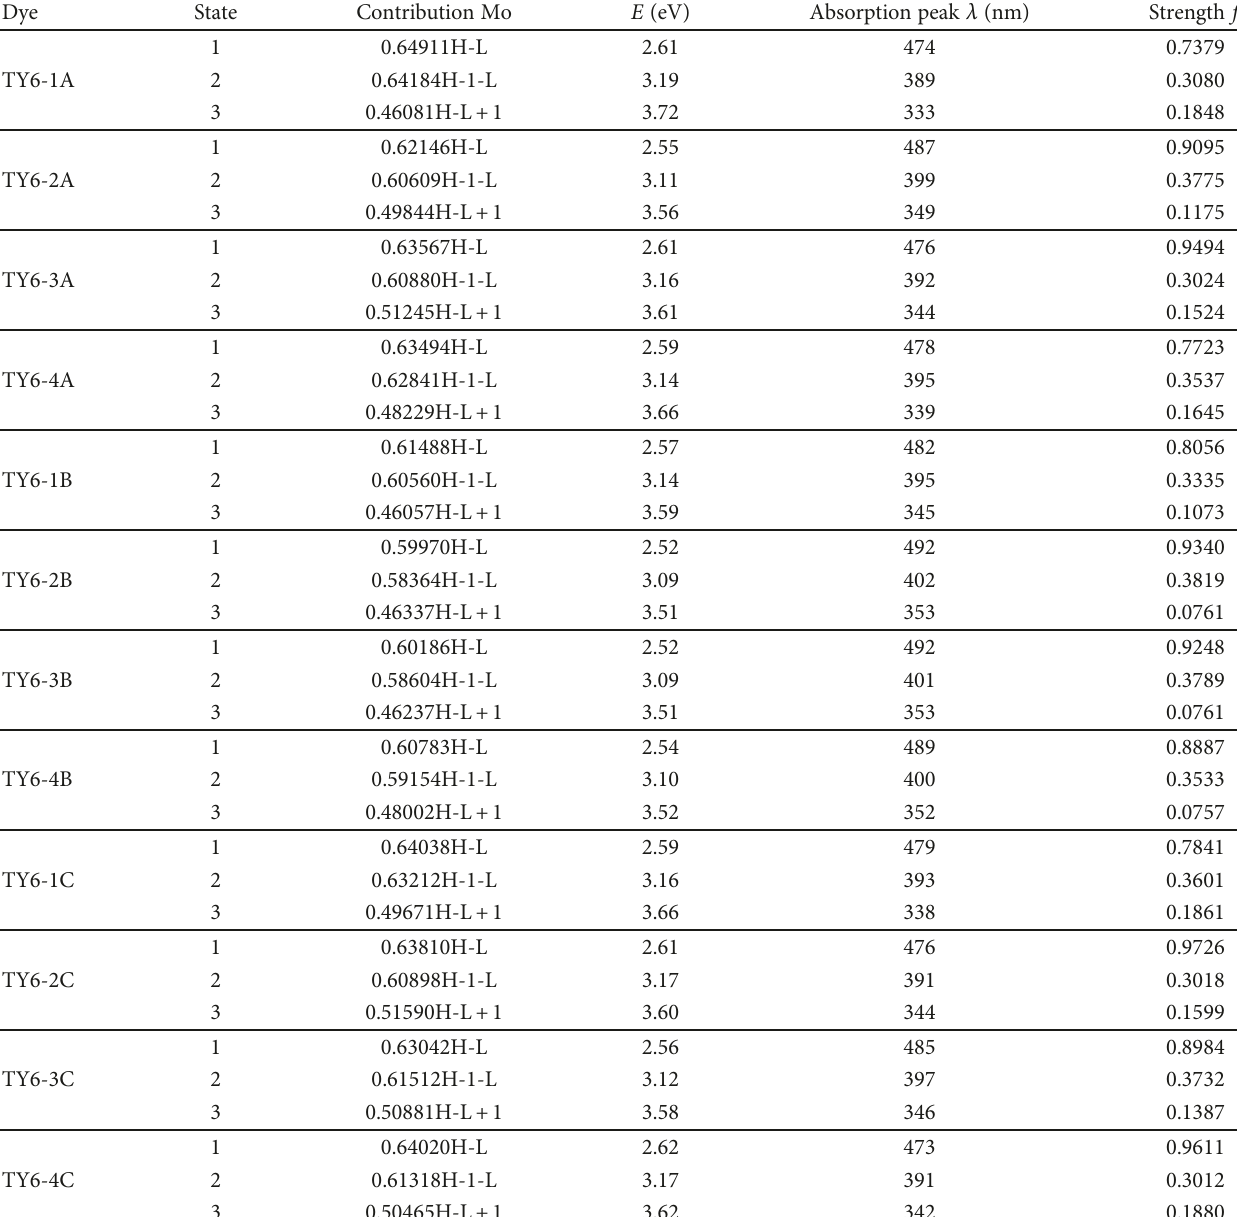
Table 12: Calculated transition energies ( E ) and oscillator strengths ( f ) of